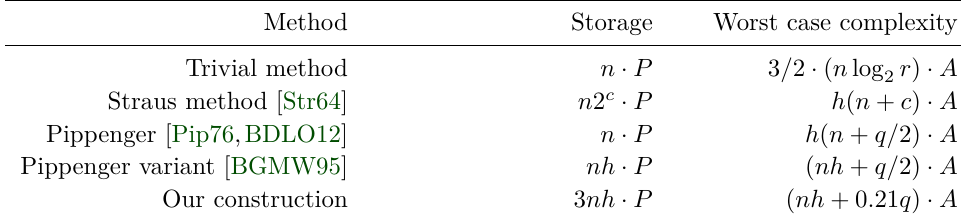
Table 1: Comparison of different methods that computes S